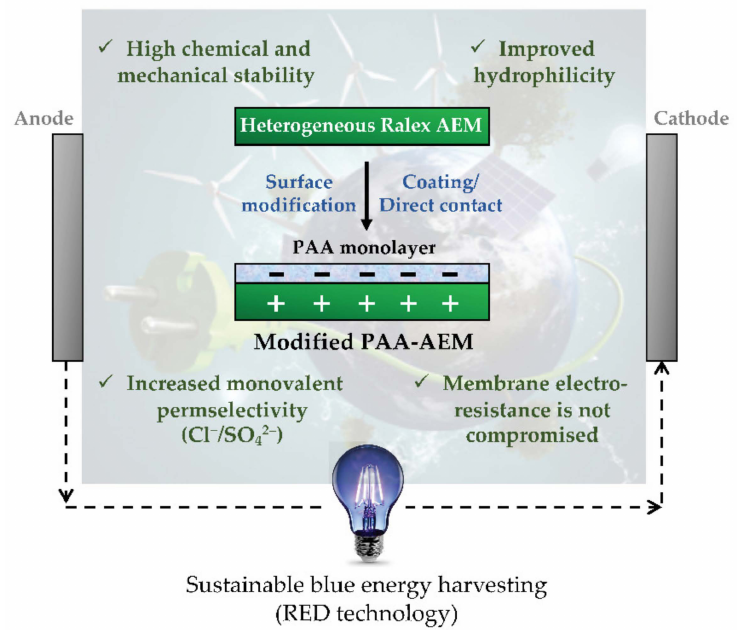
Figure 5. Scheme of the procedure used to functionalise Ralex-AEMs with poly(acrylic) acid and the advantages of the PAA modified AEMs for sustainable blue energy harvesting